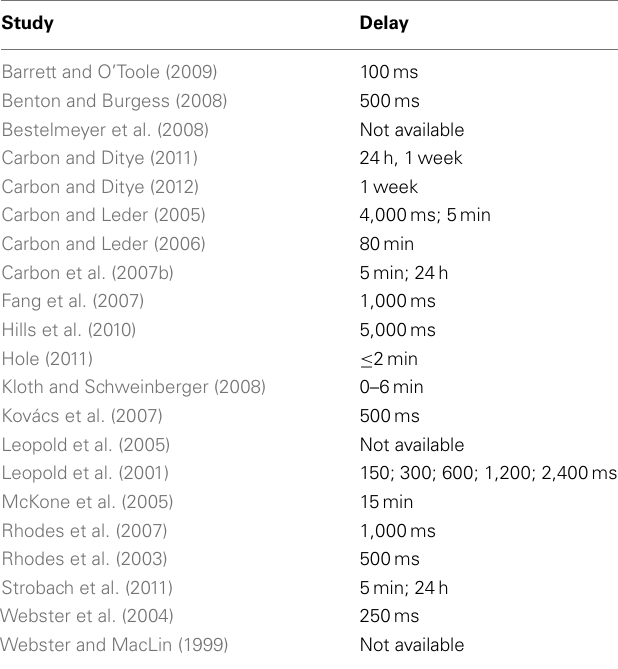
Table 2 | Overview of examples of face adaptation studies and their delays between adaptation and test